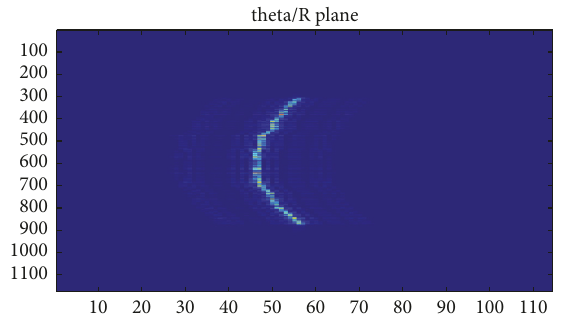
Figure 20: Angle-range